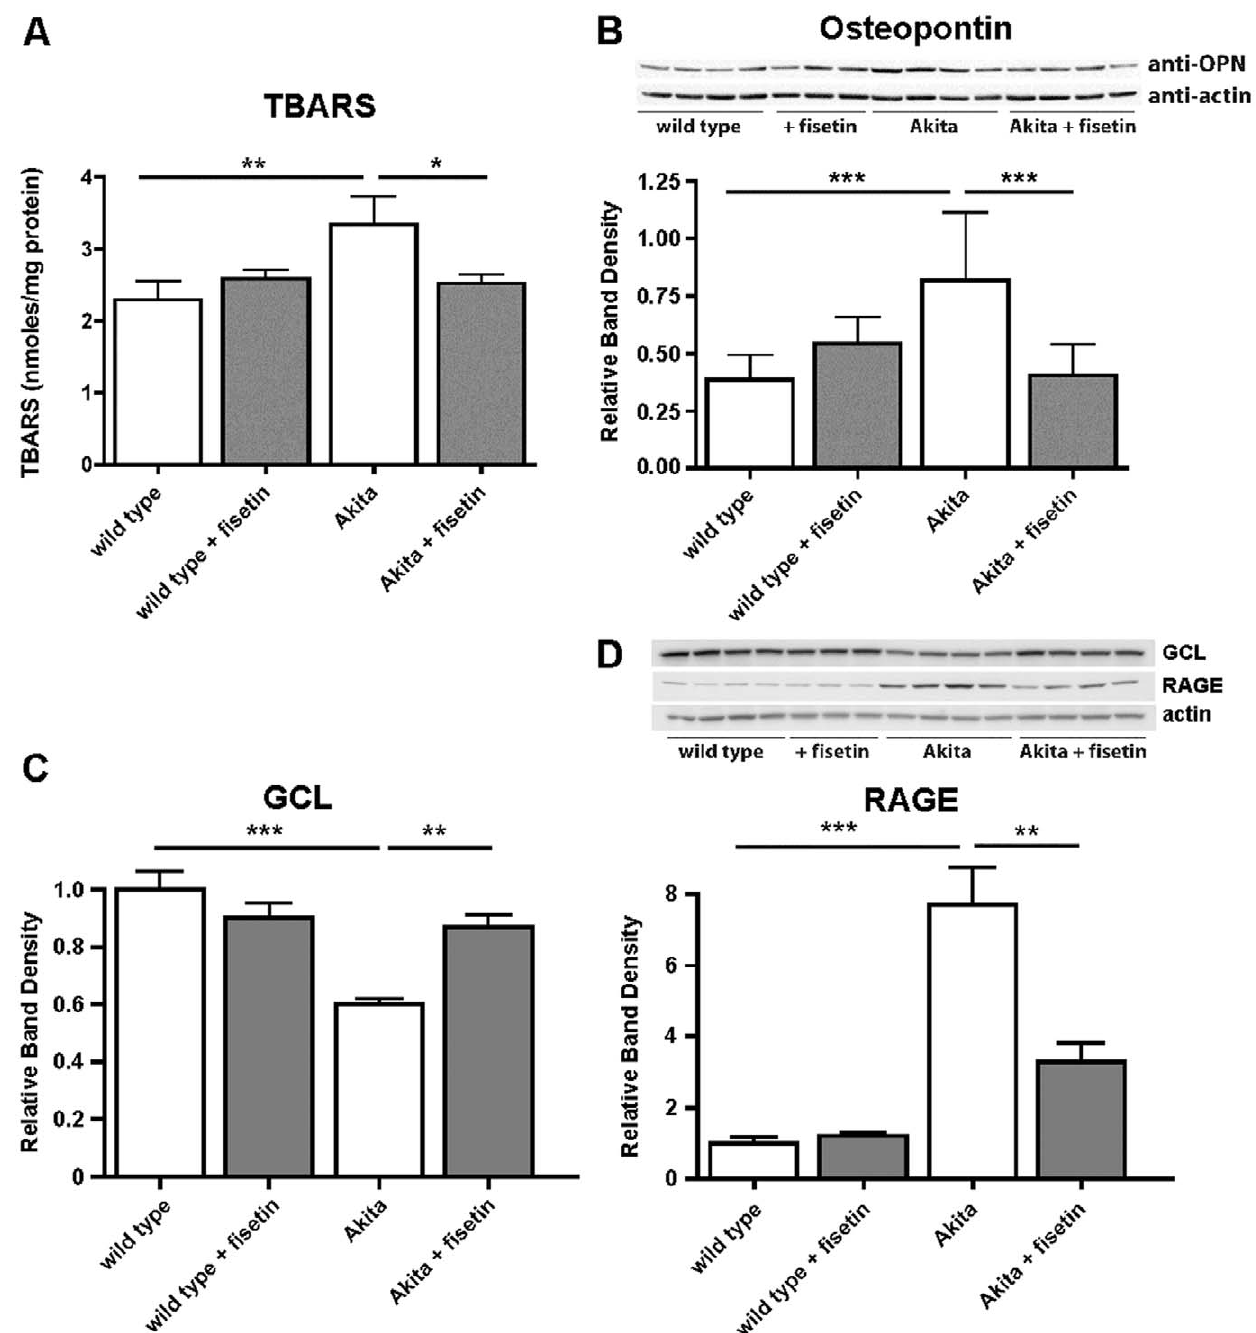
Figure 3. Fisetin reduces biochemical changes in Akita mouse kidneys. (A) The diabetes-dependent increase in TBARS is prevented by fisetin. Kidneys from wild type, wild type + fisetin, Akita and Akita + fisetin mice were homogenized in PBS containing phosphatase and protease inhibitors and equal amounts of extract were assayed for TBARS. Kidney samples from 6–7 mice were analyzed and the amount of TBARS normalized to protein. (B) The diabetes-dependent up-regulation of osteopontin (OPN) is prevented by fisetin. Kidneys from wild type, wild type + fisetin, Akita and Akita + fisetin mice were homogenized in PBS containing phosphatase and protease inhibitors and equal amounts of protein were analyzed by SDS-PAGE and Western blotting with an antibody to OPN and actin as a loading control. The expression of GCL (C) and the RAGE receptor (D) in kidneys were analyzed by Western blotting as described in (B). Kidney samples from 6–7 mice per group were analyzed and the average intensity of the GCL, RAGE, and OPN bands normalized to actin is shown in the graphs. A representative blot is shown for each. ***( p , 0.001), **( p , 0.01) and *( p , 0.05) indicate significantly different from wild type or Akita alone as determined by ANOVA followed by Tukey’s post test.